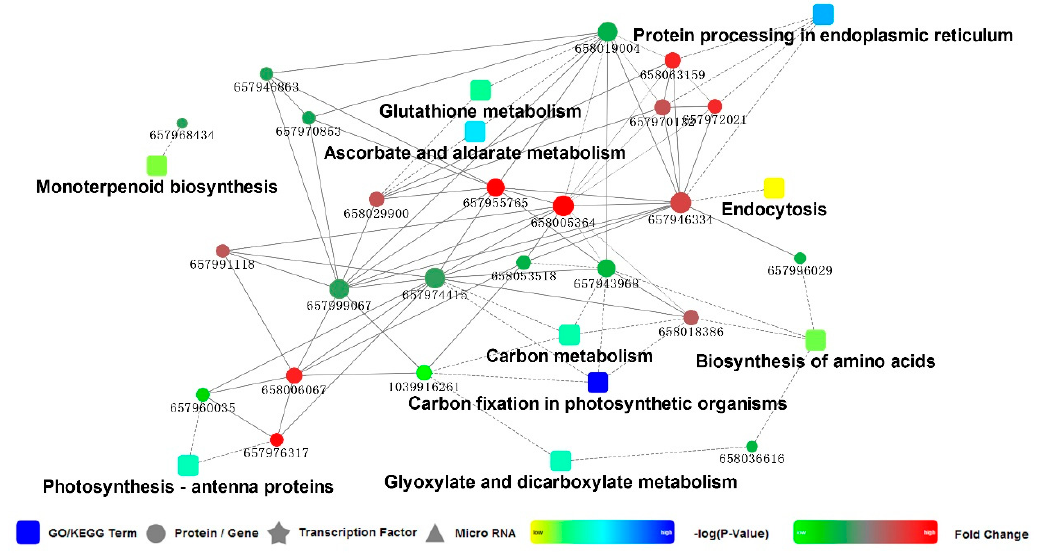
Figure 5. PPI speculation in M. ‘Prairifire’ leaves after 38 °C heat shock for 48 h.